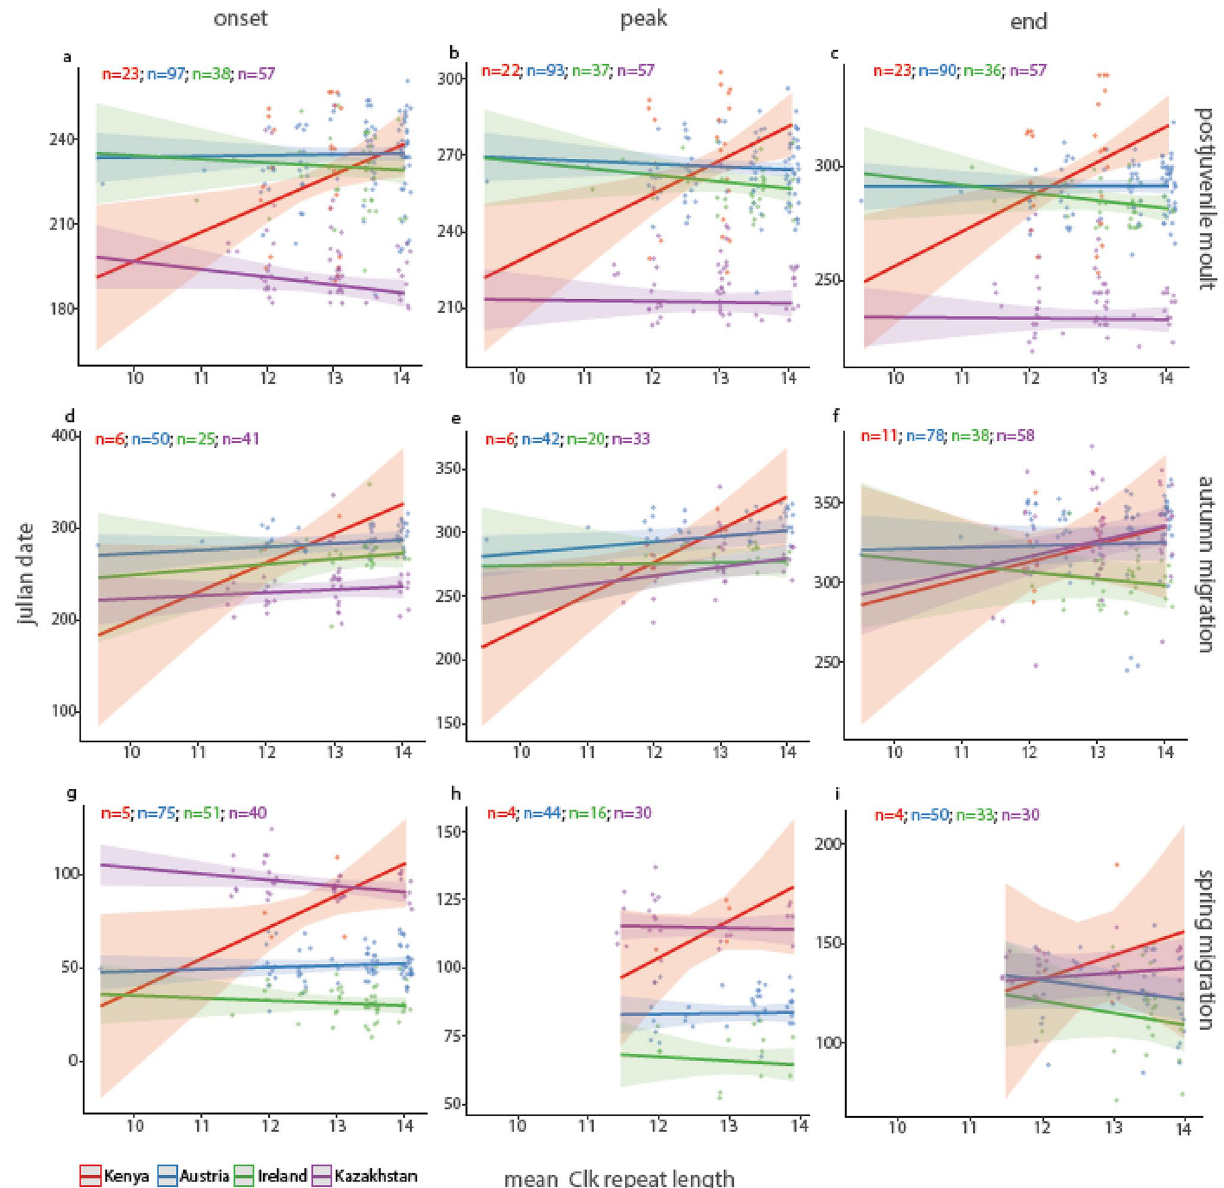
Figure 3. Timing of moult and migration in relation to population-specific Clk gene mean repeat length in stonechats. Onset, peak and end of postjuvenile moult ( a – c ) and of migratory restlessness exhibited during autumn migration ( d – f ) and spring migration ( g – i ) are shown in relation to mean repeat length for four populations: Kenyan stonechat populations plotted in red, Austrian in blue, Irish in green, and Kazakh in